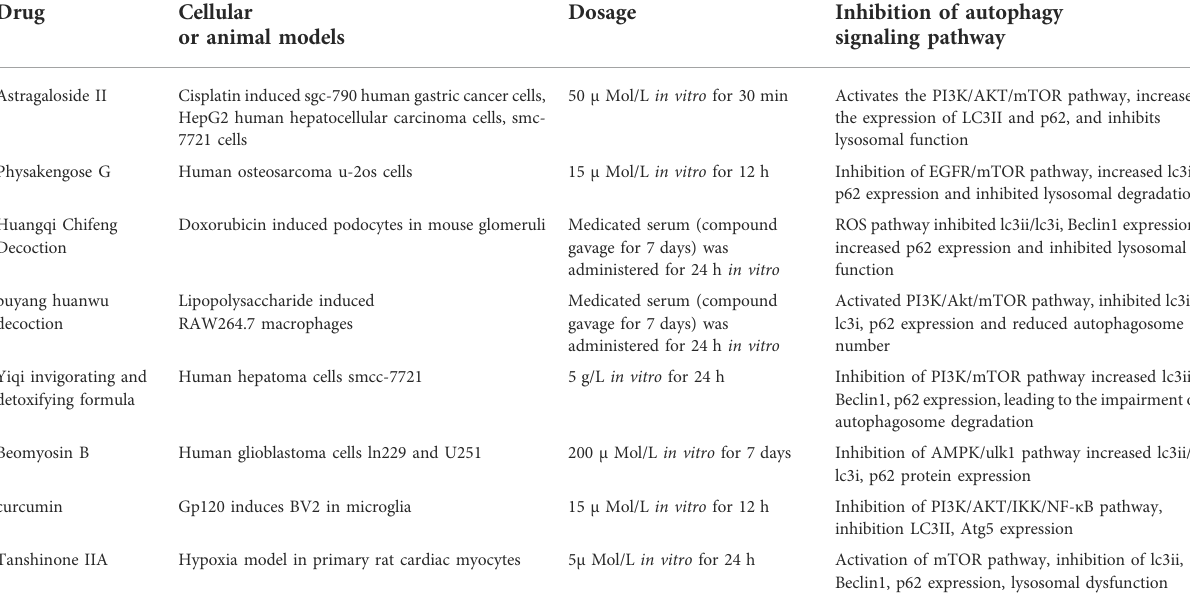
TABLE 2 Summary of drugs and mechanisms by which active ingredients and compound compounds of traditional Chinese medicine inhibit autophagy.